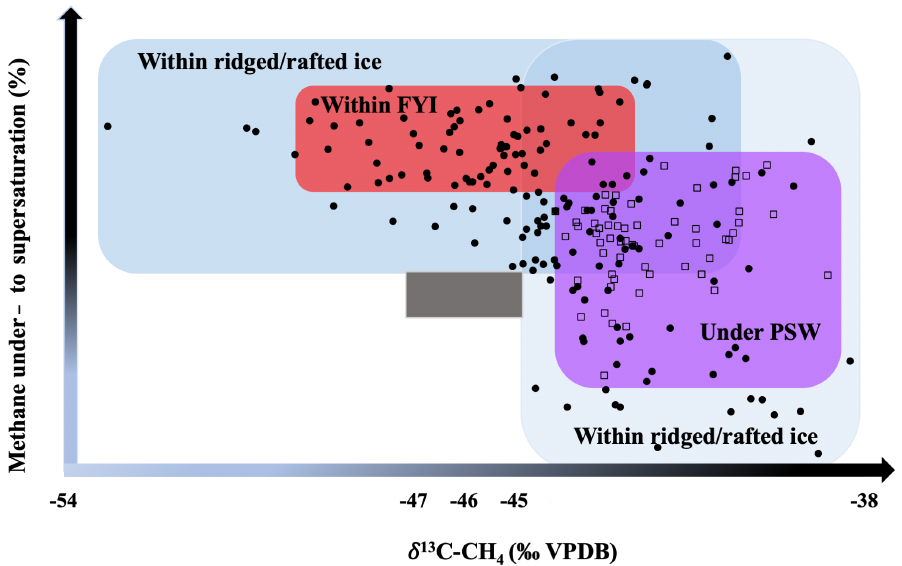
Figure 9. Variability in the methane inventories within different ice types on our ice floe and PSW underneath. The grey rectangle shows the atmospheric background